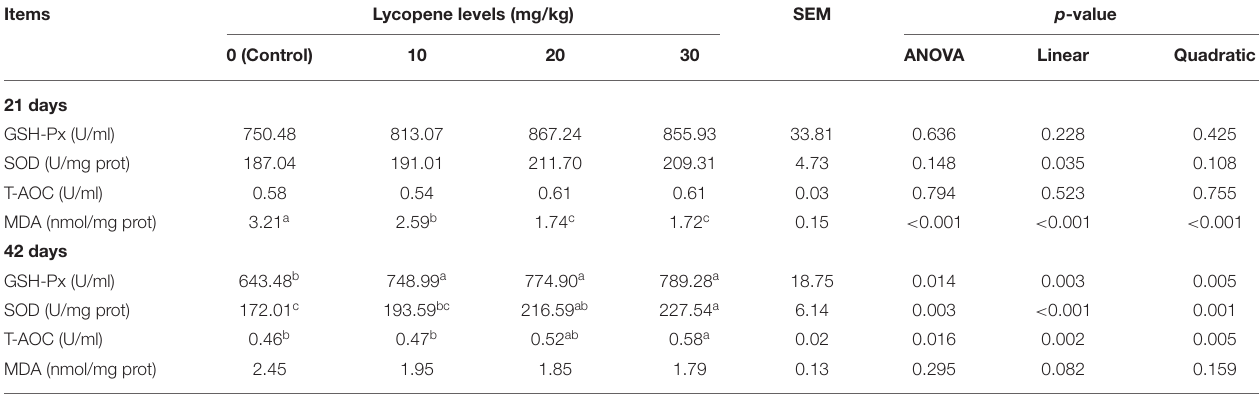
TABLE 5 | Effect of dietary lycopene on serum antioxidase of AA